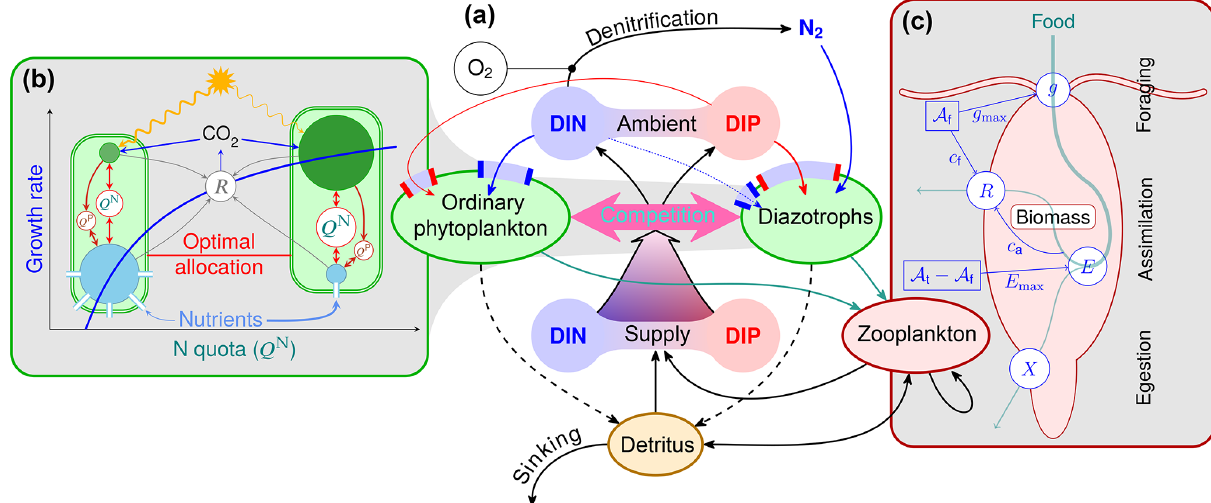
Figure 1. Optimality-based plankton-ecosystem model (OPEM, panel a ). Ordinary phytoplankton, diazotrophs, and zooplankton are repre- sented by optimality-based physiological regulatory formulations. Ordinary phytoplankton and diazotrophs are driven by optimal allocation of cellular resources (b) , balancing the benefits of nutrient assimilation and light harvesting against allocation and energetic costs (respira- tion, R ) of these processes. The optimal allocation trades off, e.g. cellular N as defined by Q N , between the requirements for photosynthesis (green) and nutrient acquisition (blue), with an additional compartment for N 2 fixation in diazotrophs (not shown). The phosphorus quota ( Q P ) controls N assimilation (see Appendix C1.2), but only Q N affects the growth rate directly (see Appendix C1.1). Zooplankton forag- ing (c) is optimised by balancing costs and benefits of allocating total activity ( A t ) between foraging activity ( A f ) and assimilation activity ( A t − A f ). Both foraging and assimilation incur energy costs ( c f and c a , respectively) fuelled by respiration ( R ). Increasing ingestion ( g ) reduces assimilation efficiency ( E ≤ E max ), causing more particulate egestion ( X ).